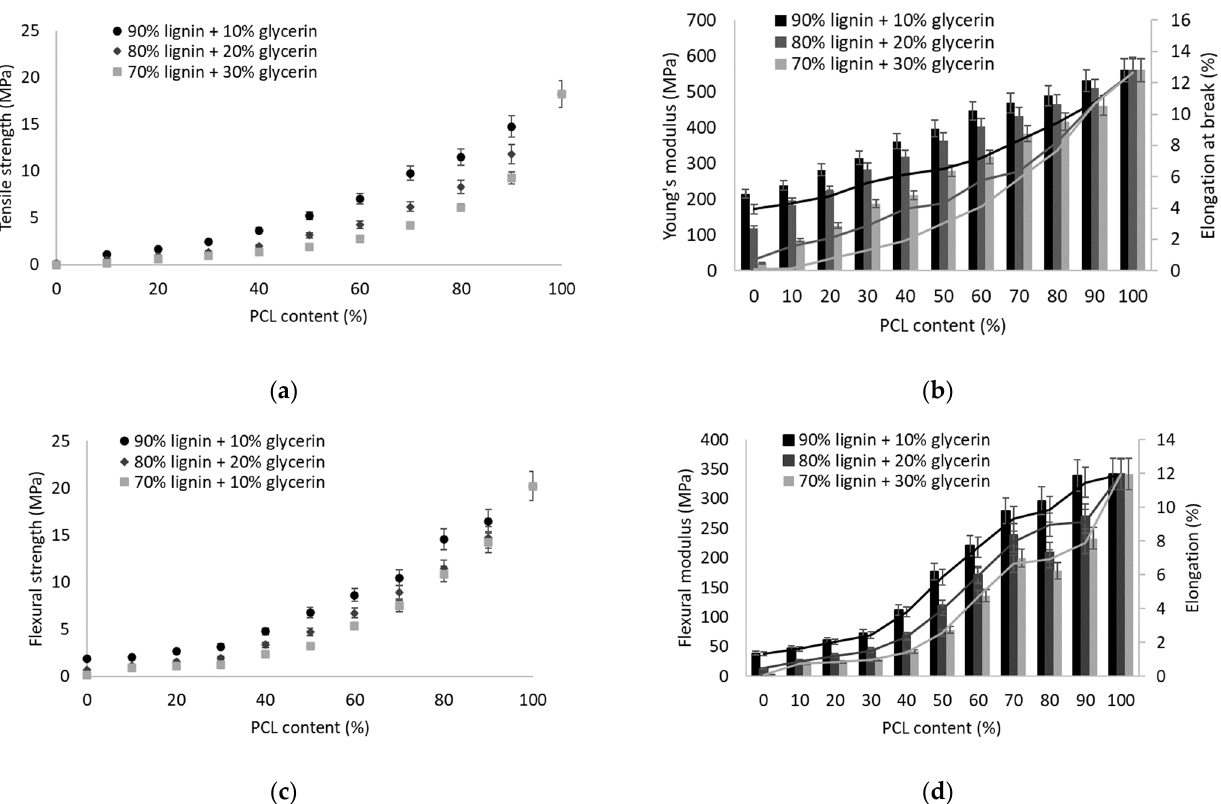
Figure 4. Mechanical properties of different TPL/PCL blends: ( a ) tensile strength; ( b ) Young’s modulus and elongation at break; ( c ) flexural strength; ( d ) flexural modulus and